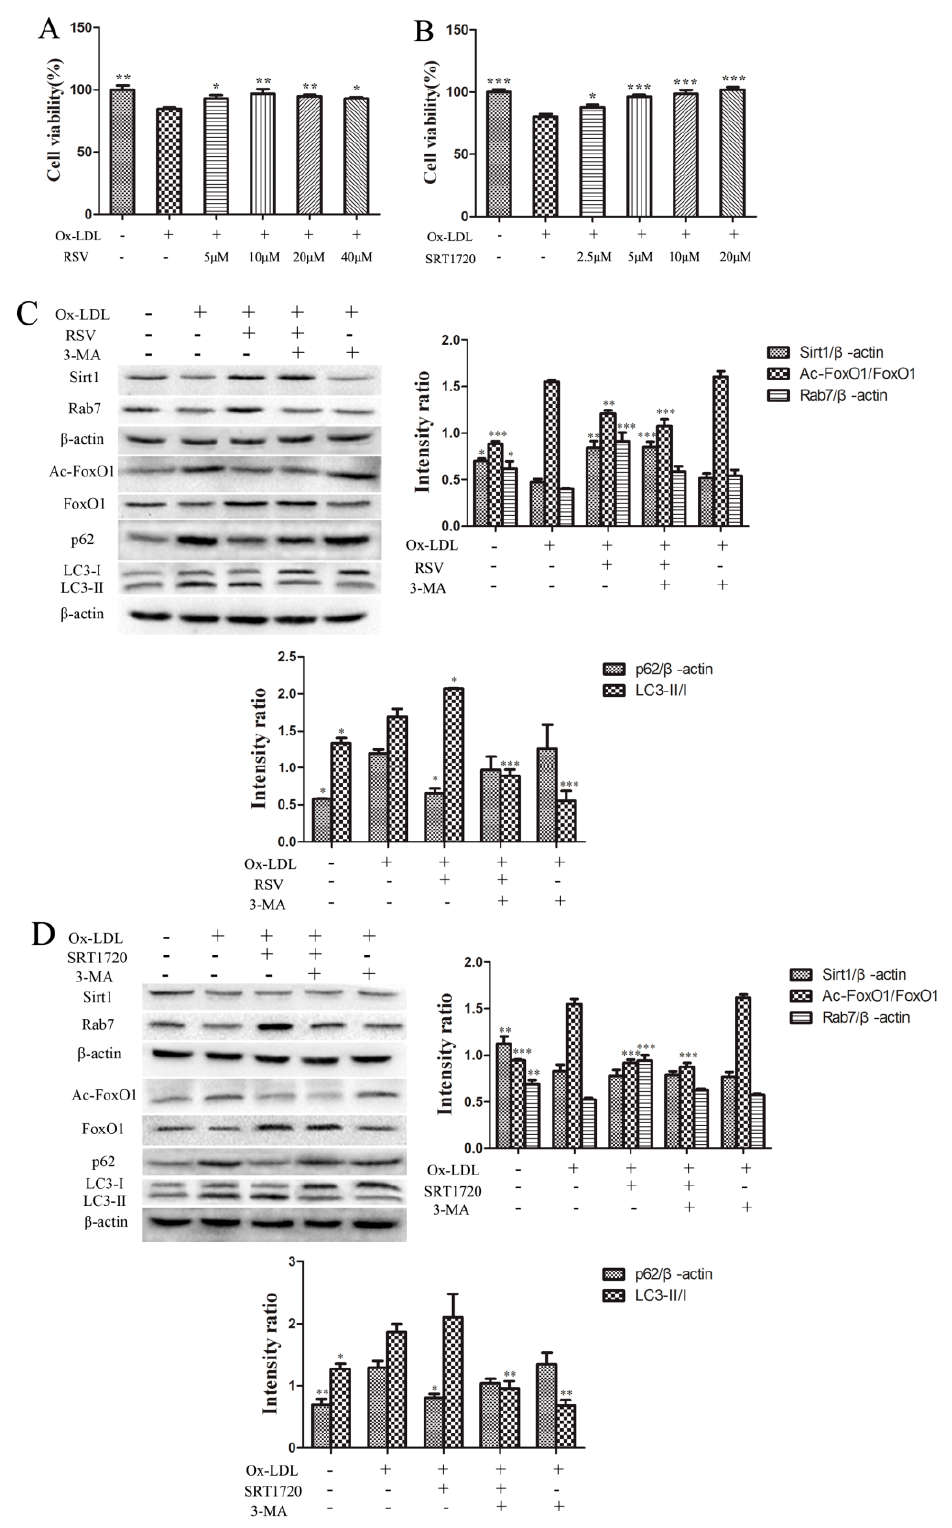
Figure 2. The viability of HUVEC treated with RSV ( A ) or SRT1720 ( B ). ( C ) Expression of Sirt1, FoxO1, Ac-FoxO1, LC3-II / I and p62 in HUVEC treated with RSV. ( D ) Expression of Sirt1, FoxO1, Ac-FoxO1, LC3-II / I and p62 in HUVEC treated with SRT1720. Values are presented as the means ± SD (MTT assay: n = 6; Western Blot: n = 3). Compared with the ox-LDL group, * p < 0.05, ** p < 0.01, *** p < 0.001.